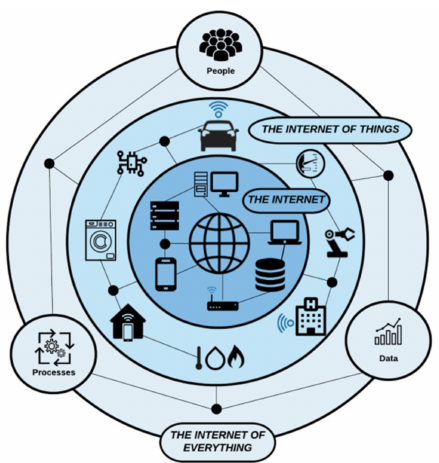
Figure 1. Cross-domain data interoperability is the key enabler for the evolution of the Internet